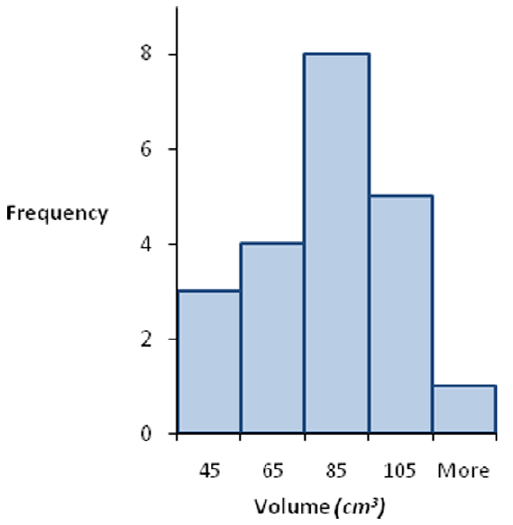
Figure 4. The histogram of pancreatic volume in studied